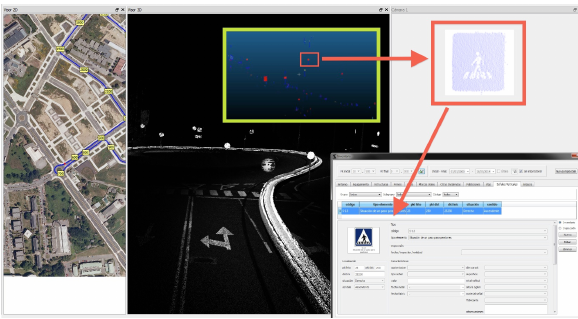
Figure 7. Detection and inventorying of traffic signs from MLS data.